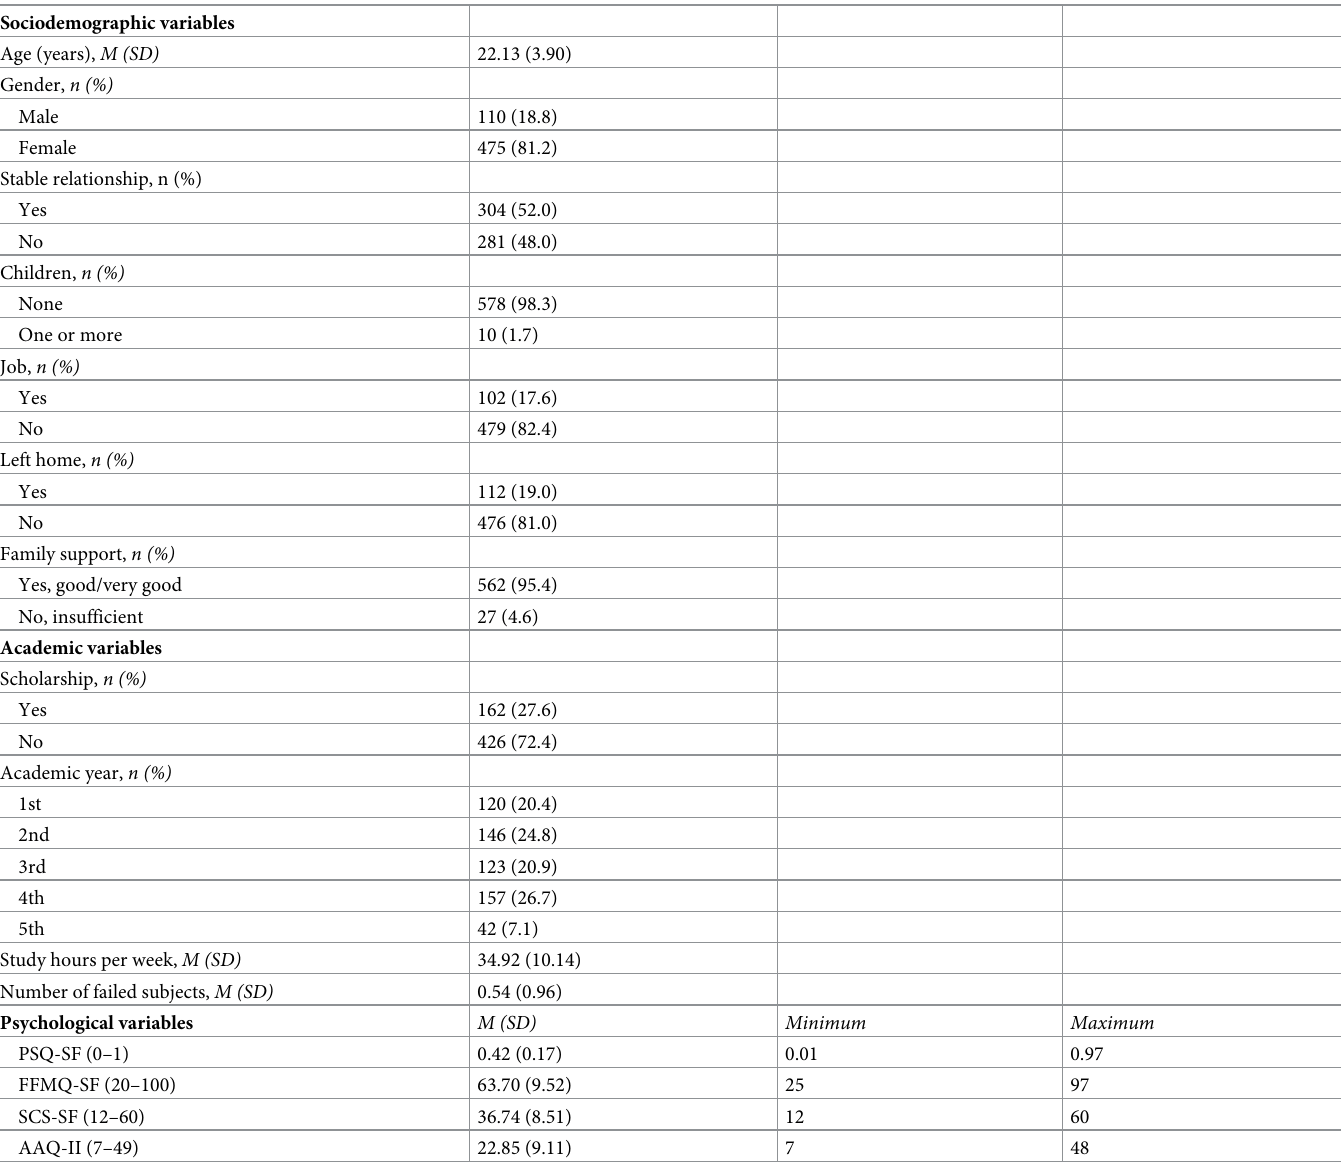
Table 1. Sociodemographic, academic, and psychological characteristics of the sample (n = 589). Sociodemographic